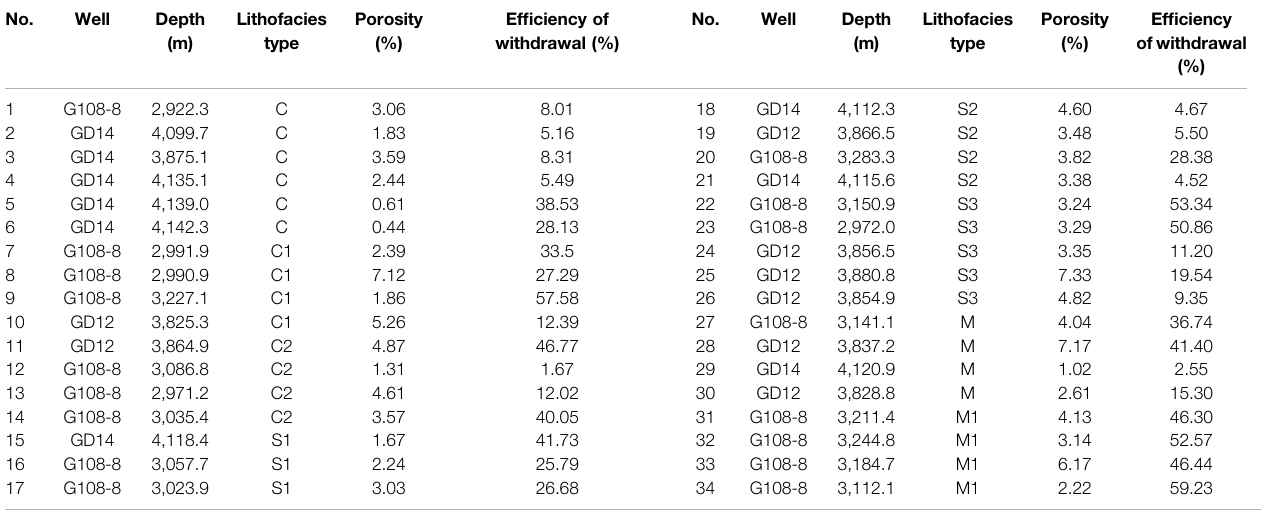
TABLE 2 | Pore structure parameters of typical samples from different lithofacies.